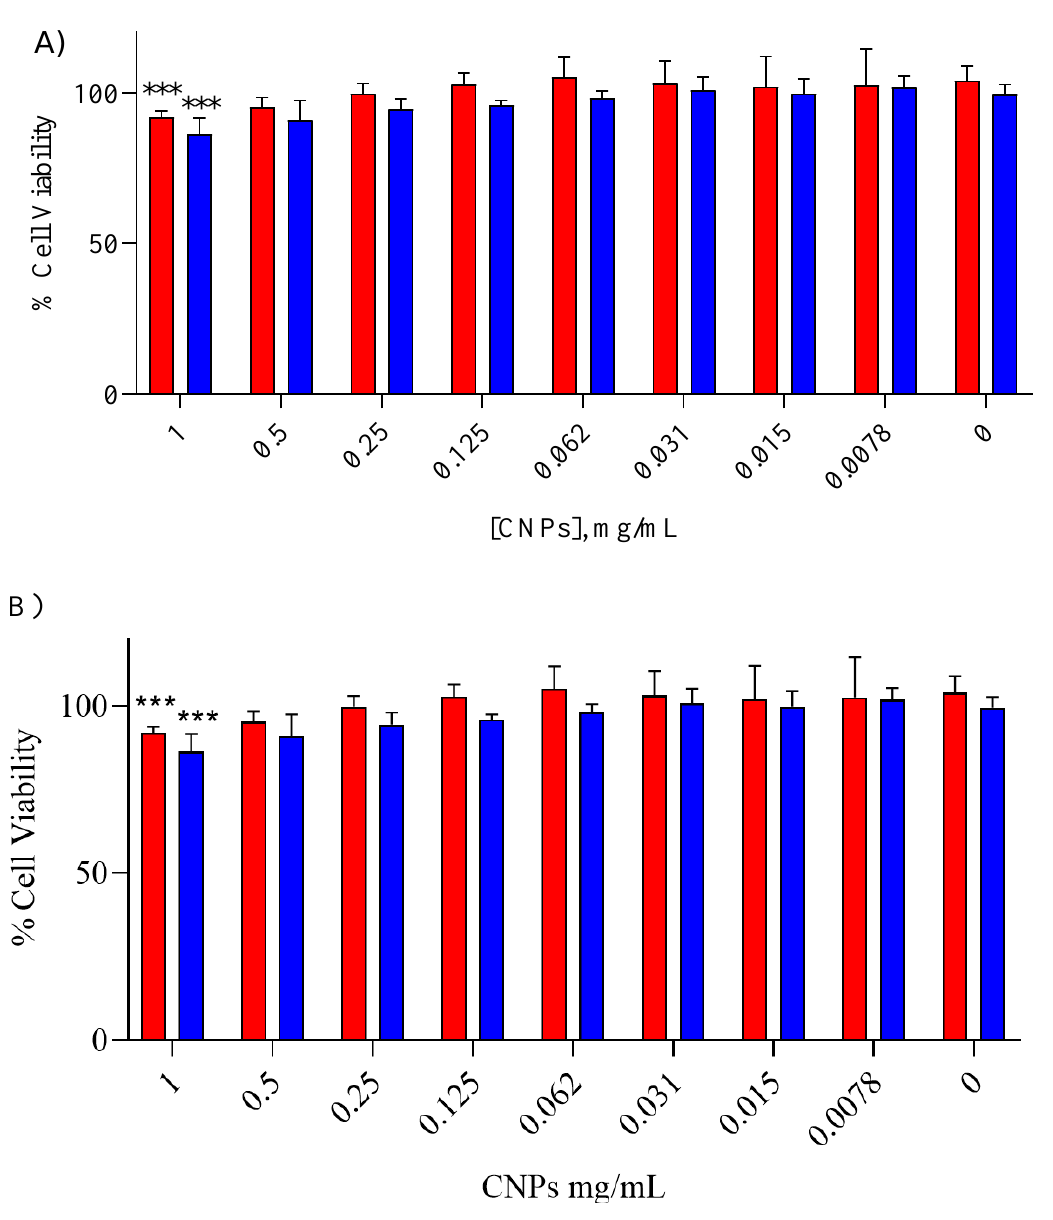
Figure 5. Cell viability assays in ( A ) HeLa and ( B ) EA.hy926, treated with CNP-1F (red) and CNP-2A (blue). The results shown represent 4 replicates per experiment. In both cell lines, untreated cells were used as controls. Values were compared using one-way ANOVA and express percent viability ± SD versus nanoparticle concentration. *** indicates p < 0.001, compared to control.